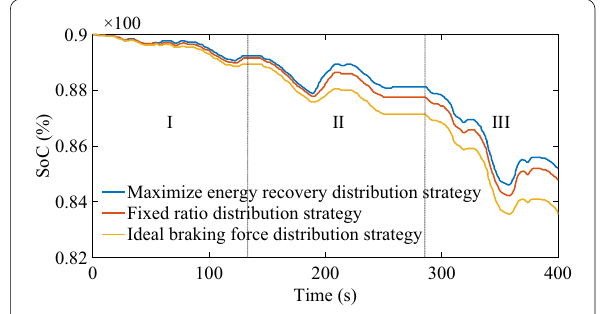
Figure 12 Simulation results of the battery SoC